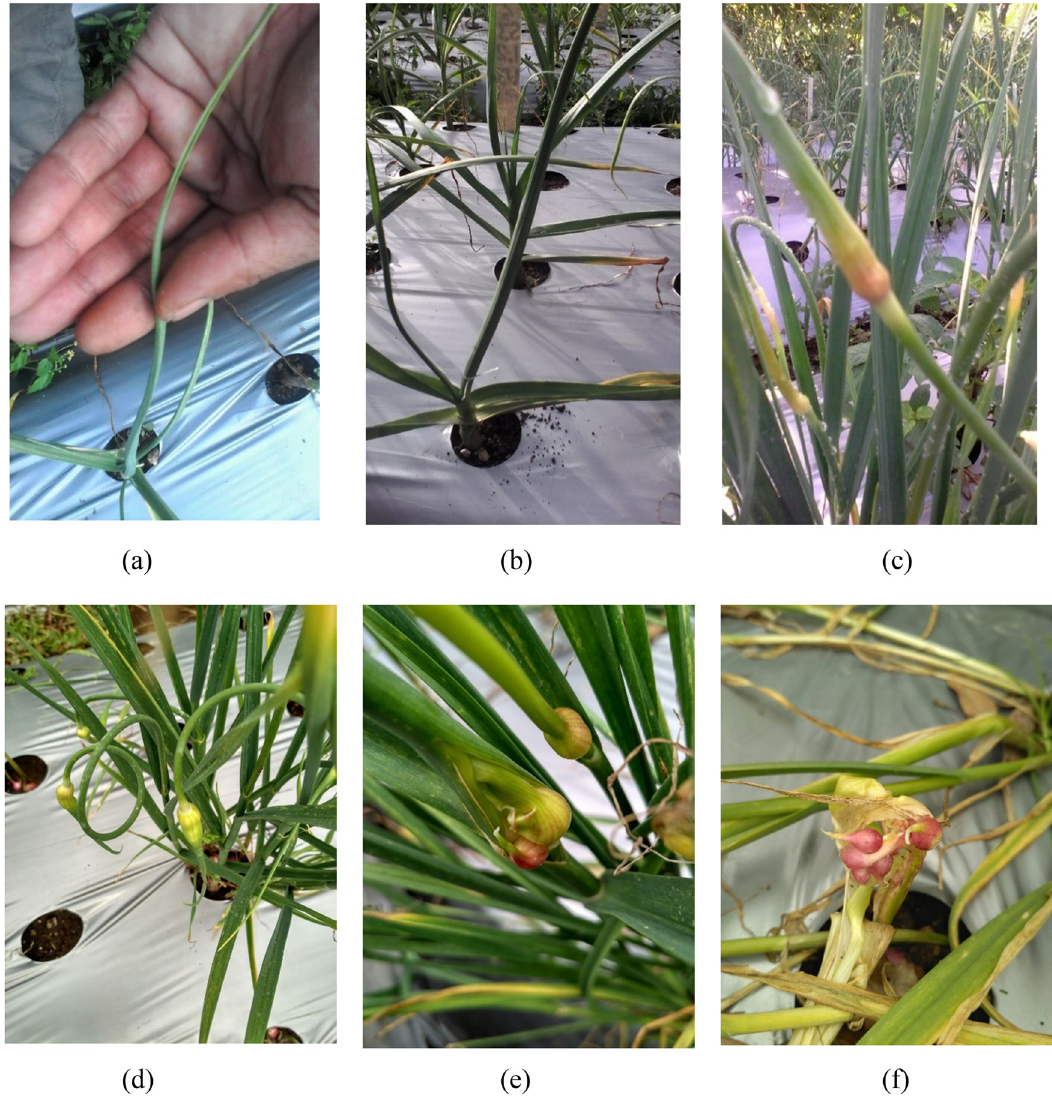
Figure 1: Bulbils emerging process. ( a ) Initial emerging of fl ower stalk. ( b ) Flower stalk growing up higher and bigger. ( c ) Tip of fl ower stalk getting bigger. ( d ) Bulbils start to emerge at the tip of fl ower stalk. ( e ) Bulbils emerge in the middle of fl ower stalk. ( f ) Bulbils emerge at the tip of fl ower stalk/primordia fl ower. ( Photo courtesy: Chotimatul Azmi )